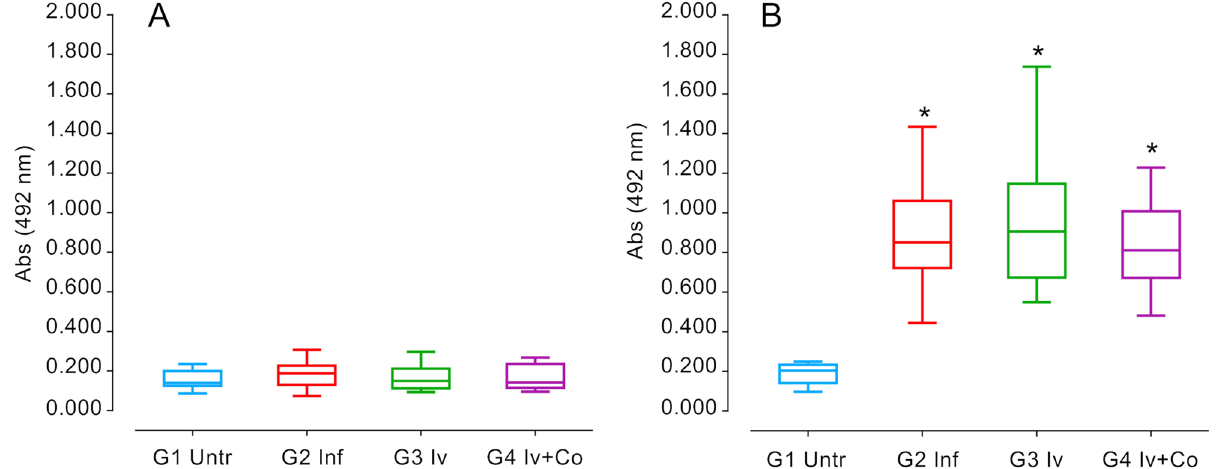
Figure 7. ELISA detection of specific IgG antibodies to SoSmAWA antigen at the beginning of the experiment ( A ) and 8 weeks post-infection ( B ) of mice treated with ivermectin (Iv) and Ivermectin + cobicistat (Iv + Co) and infected with 150 cercariae by S. mansoni (Inf). *Statistically significant differences p < 0.05 compared to untreated controls (Untr).